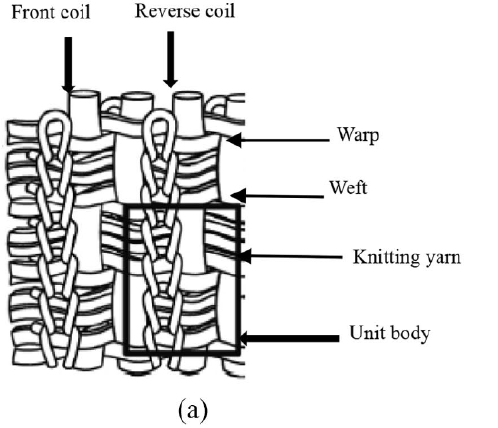
Figure 13. Co-woven-knitted fabric: ( a ) structure diagram, ( b ) fabric map. Reprinted from